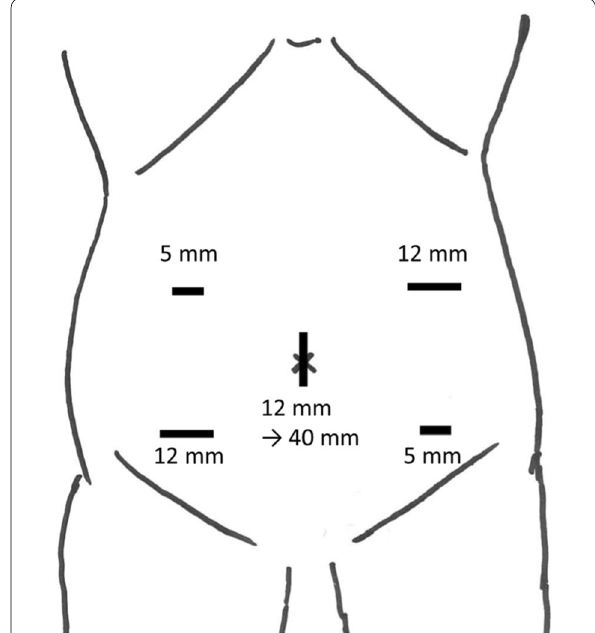
Fig. 4 Placement of ports and skin incision for laparoscopic total colectomy. We inserted the laparoscopic trocar and ports as shown in the figure. The umbilical incision was extended to up to 40 mm to remove the colon